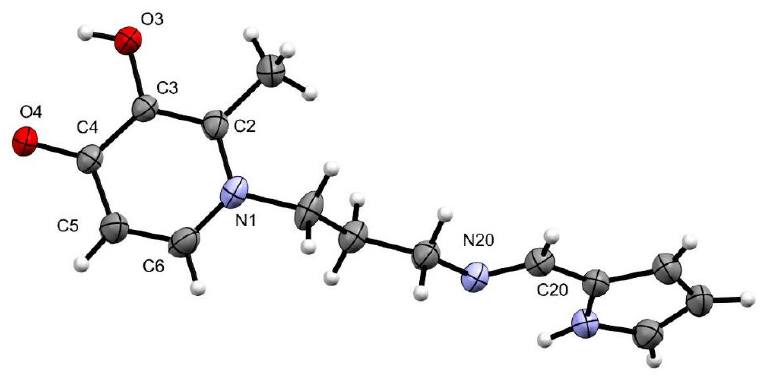
Figure 3. Molecular structure of H(L2) showing thermal displacement ellipsoids, drawn at the 50% probability level. Key bond lengths (Å ) and angles (°) are C4-O4 1.269(2), C3-O3 1.354(2), C3-C2 1.371(3), C6-C5 1.351(3), C2-N1 1.369(3), C6-N1 1.351(3), N20-C20 1.265(3); O4-C4-C3 121.14(18), O3-C3-C4 119.94(17), C2-N1-C6 120.05(17).